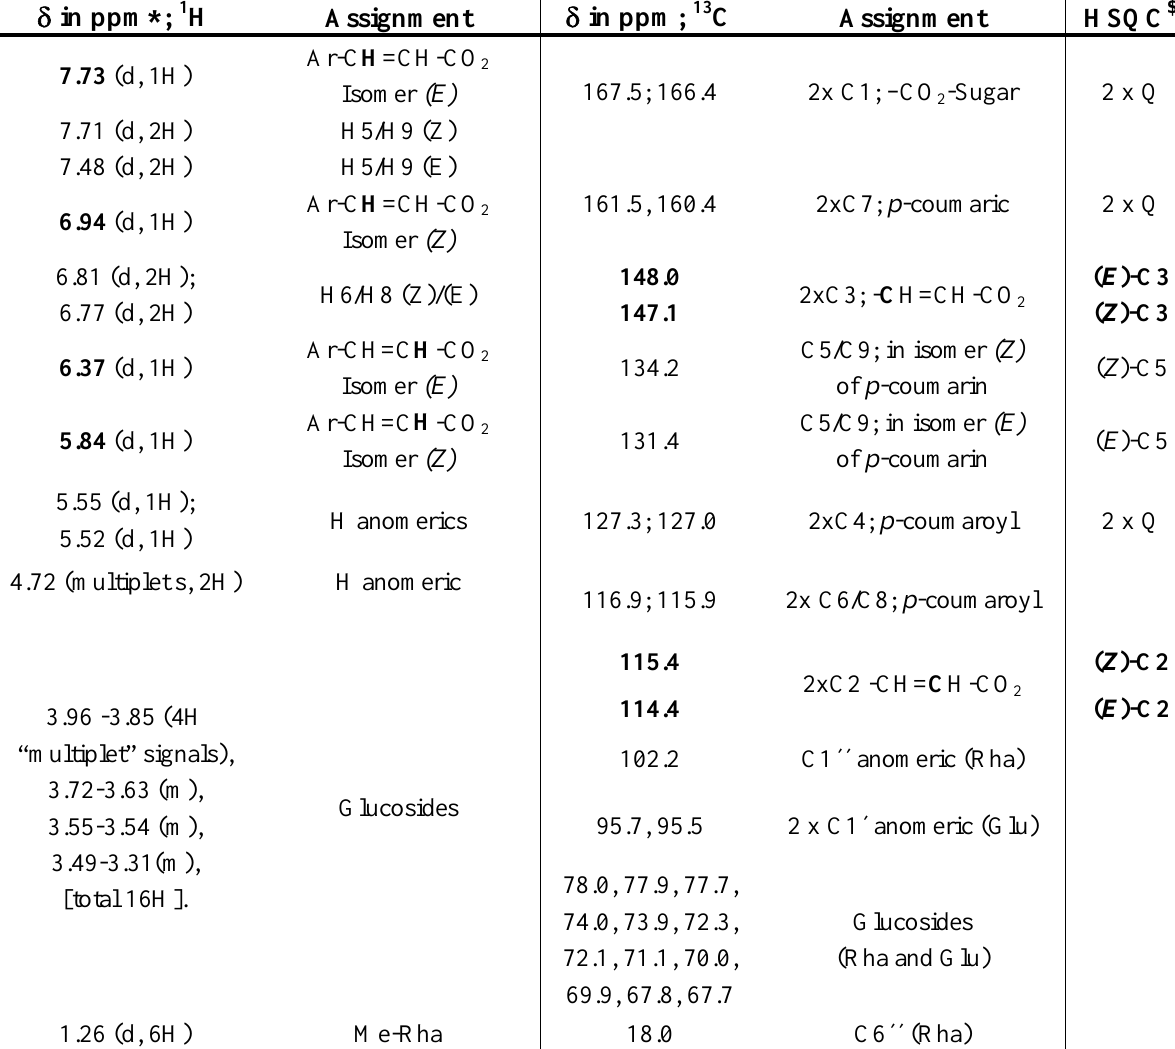
Table 1 . NMR spectral data of the mixture of the two Z and E isomers of the p -coumarate of 1- O -rutinose δ in ppm*; 1 H Assignment δ in ppm; 13 C Assignment HSQC